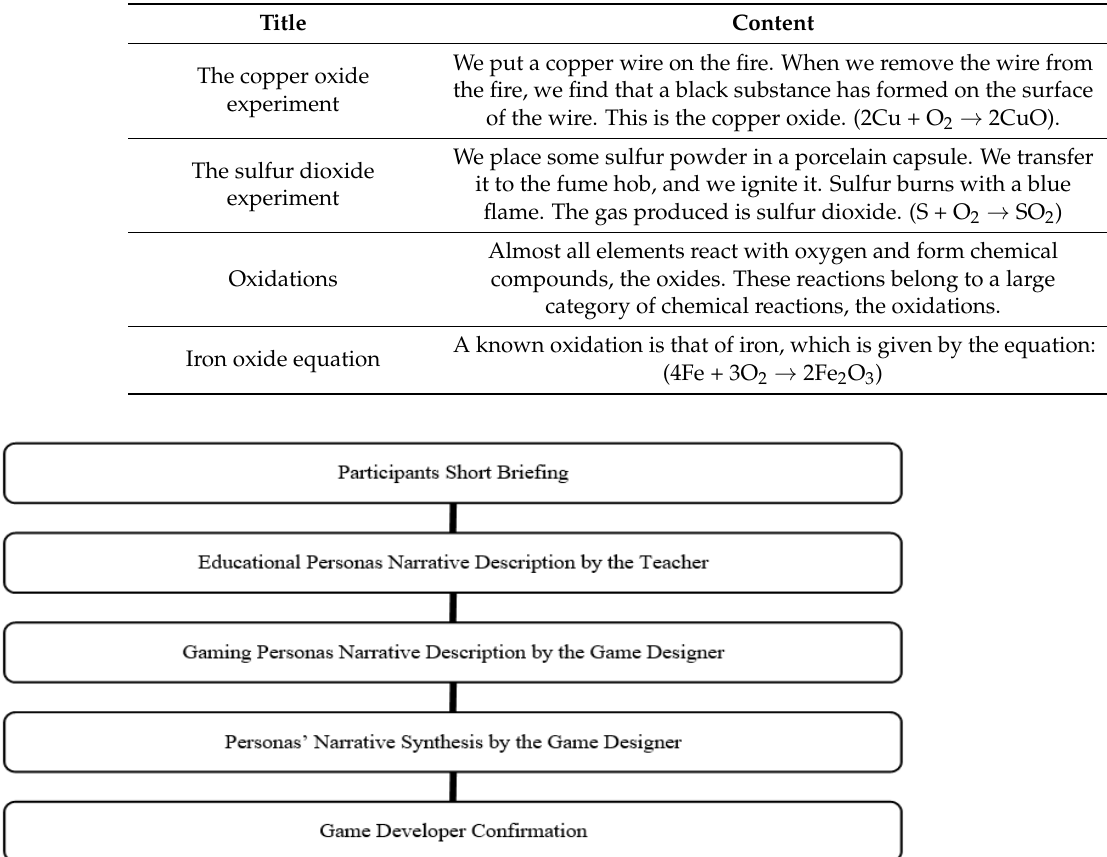
Figure 6. The Game Design Process.